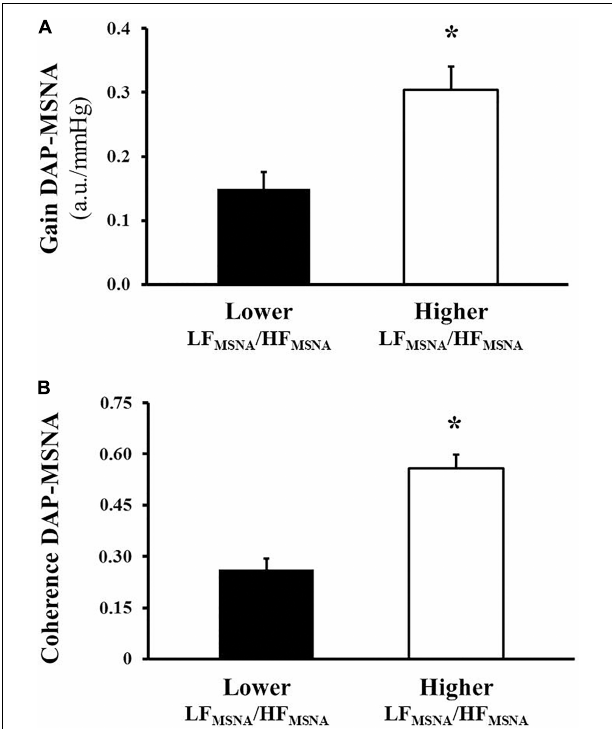
FIGURE 2 | Sympathetic baroreflex function of muscle sympathetic nerve activity (MSNA), assessed by the transfer function technique using bivariate autoregressive spectral analysis, in heart failure patients with reduced ejection fraction. The levels of gain are expressed in arbitrary unit/mm of mercury (u.a./mmHg, A ) and coherence in percentage (B) . * P < 0.01 vs. Group with higher oscillatory pattern of MSNA.